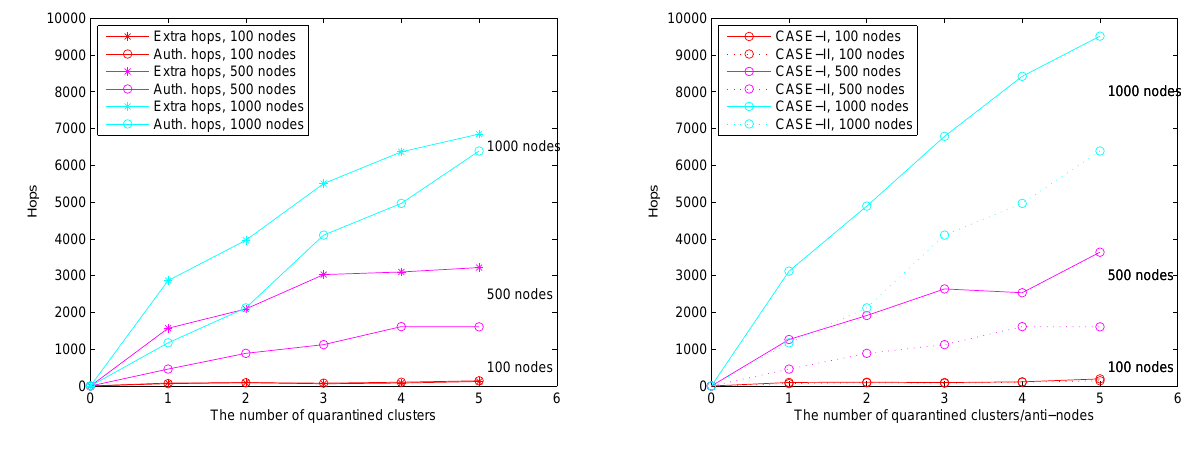
Figure 16. Case II: the number of extra hops for bypassing routing path and the number of authenticated hops for going through the quarantined clusters (left); the comparison of authenticated hops of Case I and Case II